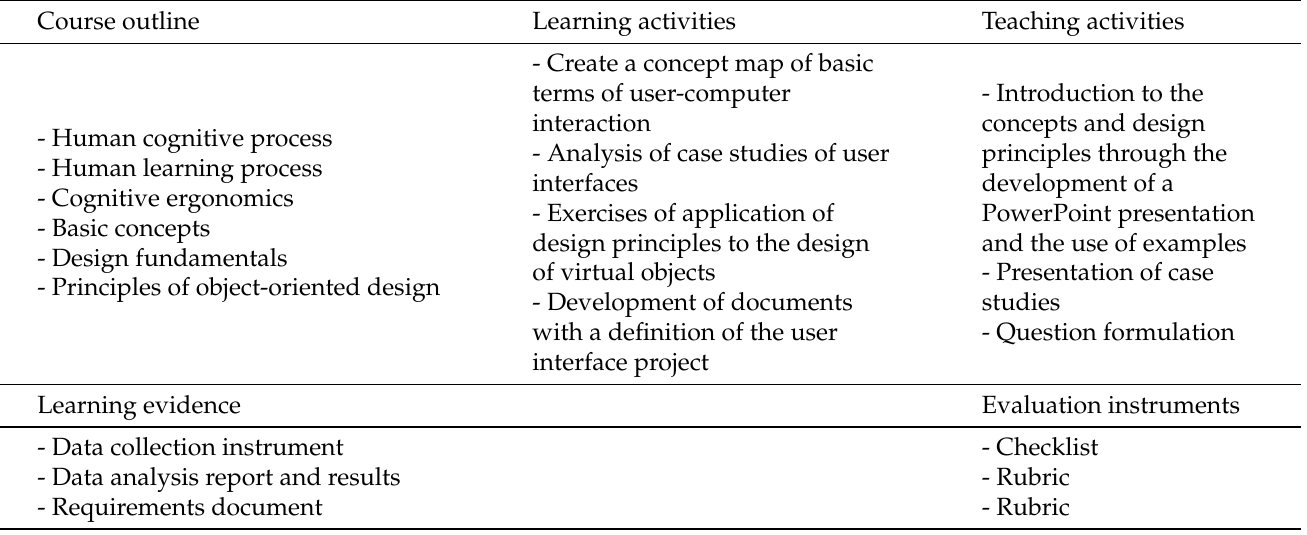
Table 1. Didactic planning, unit I of computer engineering